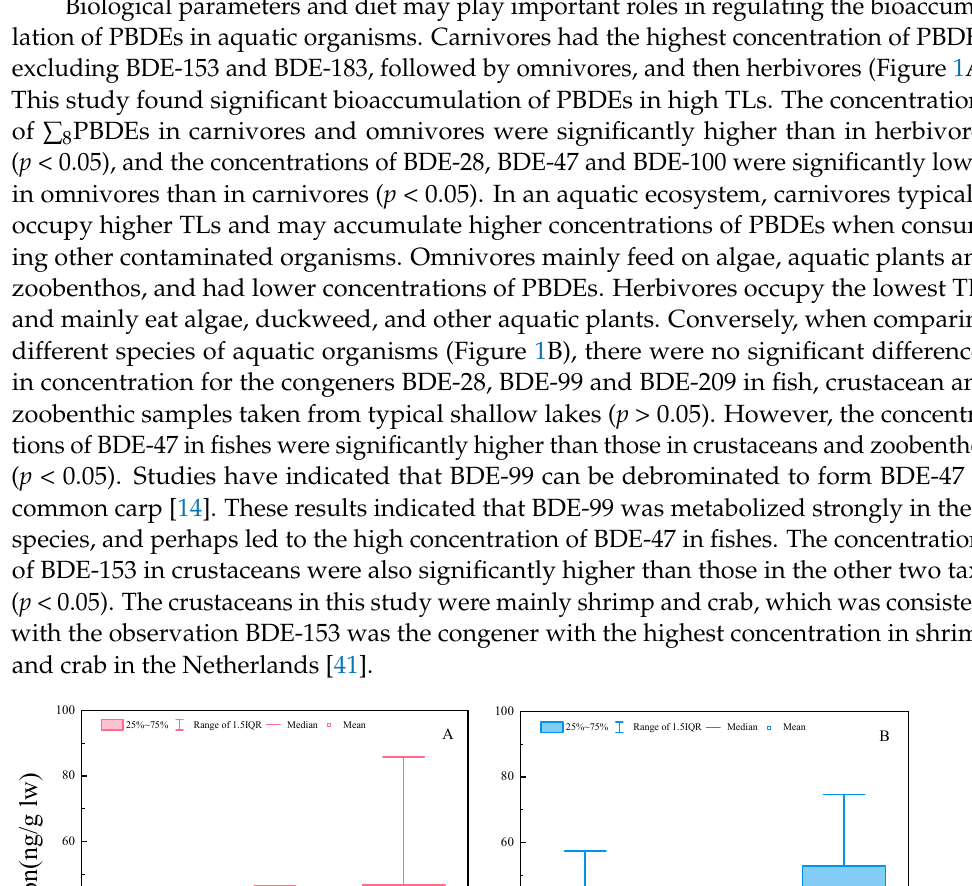
2.65% of Σ 8 PBDEs. The results of the BDE-209 analysis were similar to those of the pre- dominant congener in the Yellow River and Pearl River sediments [42,43]. Since the United Nations banned the production and usage of commercial Penta- and Octa-BDE in 2009, China has begun to widely use Deca-BDE, mainly BDE-209. This is also consistent with the results that BDE-209 was the predominant congener detected by Wang, Jia, Gao, Zeng, Li, Zhou, Sheng, and Yu [29] in the sediments of Taihu Lake, indicating that Deca- BDE is the primary commercial product in the Taihu Lake basin. In addition, Luo, et al. [44] found that BDE-209 had a lower metabolic velocity, and that BDE-99 had one of the fastest metabolic velocities of PBDEs in aquatic organisms. This was probably why BDE- 209 was a predominant congener but BDE-99 was not. However, Zeng, et al. [45] found that common carp could debrominate BDE-99 to BDE-47 and debrominate BDE-183 to BDE-154, and that BDE-209 could also be debrominated and metabolized into a low-bro- minated congener, so while the concentration of BDE-209 in common carp was low, BDE- 47 and BDE-153 were the dominant congeners. A number of studies have demonstrated that debromination in fish is species-specific and affected by fat content and diet [46]. Ad- ditionally, this study found a similar pattern in the concentrations of BDE-47 in aquatic organisms to the general pattern of BDE-47 dominance in aquatic species [47]. One study showed that highly brominated congeners were debrominated into BDE-99 and then BDE-47; therefore, the metabolism of highly brominated PBDE congeners in aquatic or- ganisms may be responsible for this result [48]. Interestingly, aquatic organisms tended to preferentially accumulate BDE-153 in addition to BDE-47 and BDE-209. Similar results